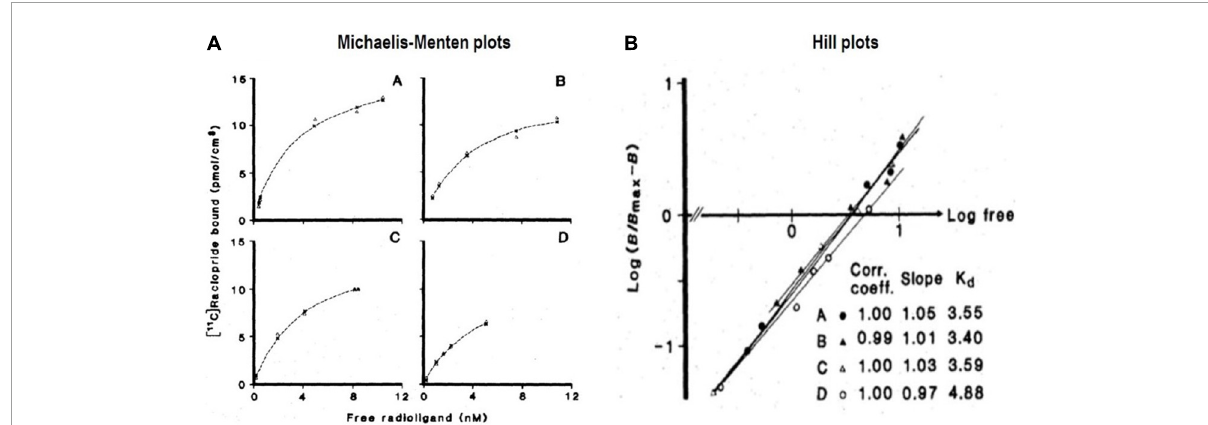
FIGURE9 Transient Equilibrium Method (TEM): From bound tracer to maximum binding capacity. (A) Shows Michaelis and Menten (1913) plots of bound quantities of tracer [ 11 C]raclopride vs. free radioligand concentrations (nM) of four healthy subjects (A–D) in human putamen). (B) Shows Hill plots of half-saturation concentration ( K D ) determination from striatal binding of [ 11 C]raclopride administered to the four subjects, yielding K D values from intersection with abscissa and B max values obtained from analysis shown in (A) (adapted from Farde et al.,